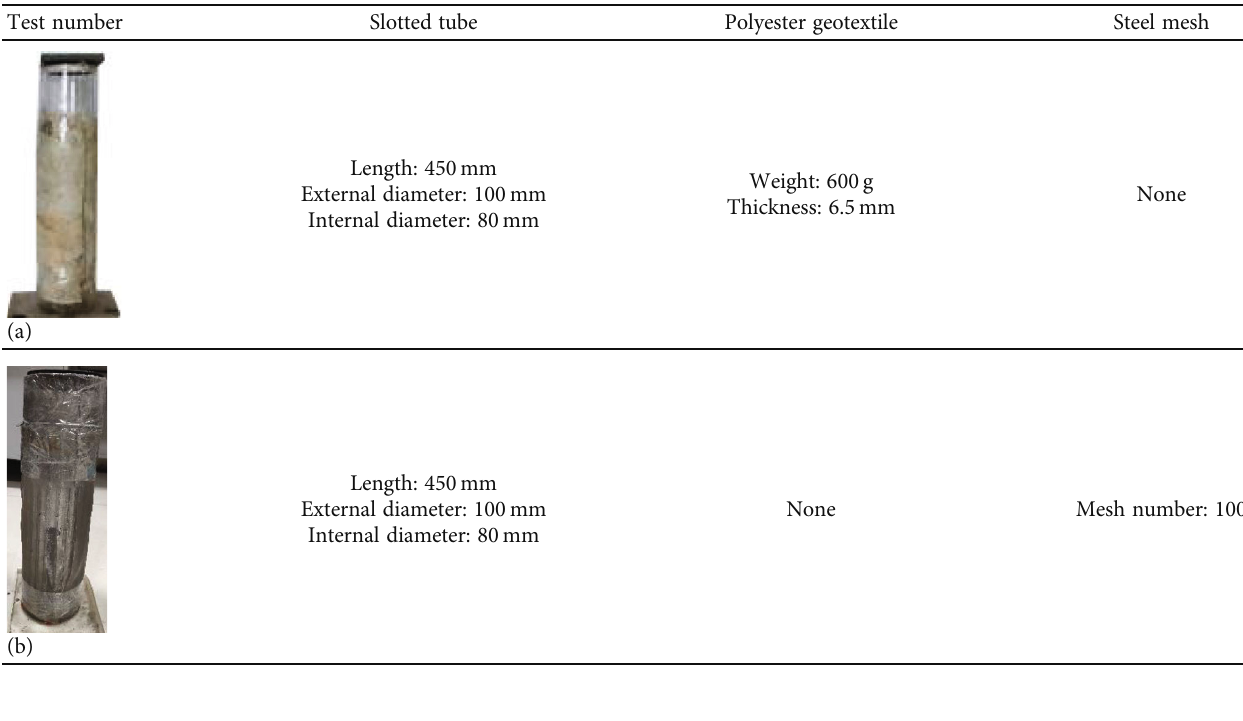
Table 2: Tailing sand